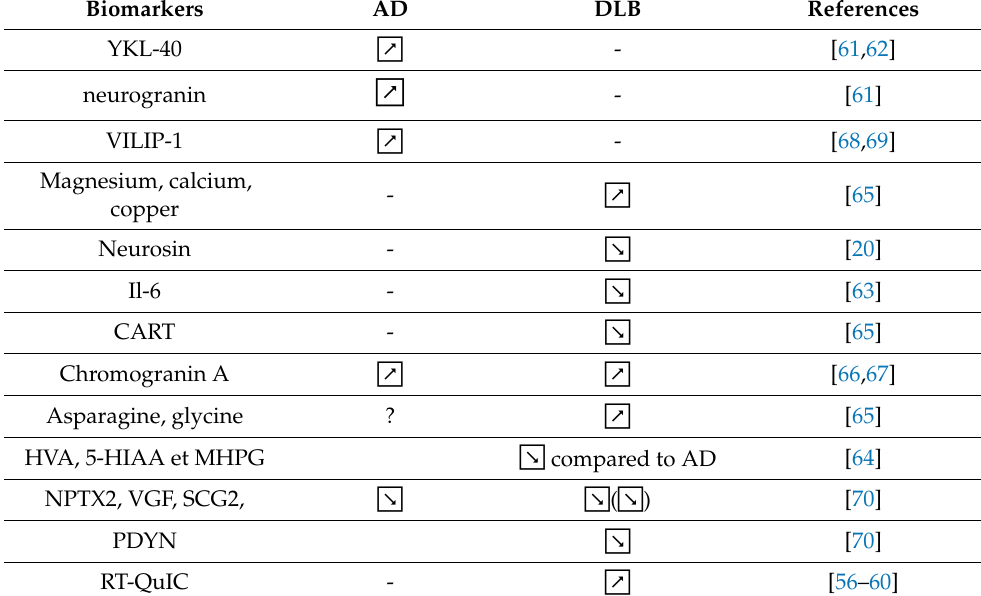
↗ means increased compared to controls, ? means no